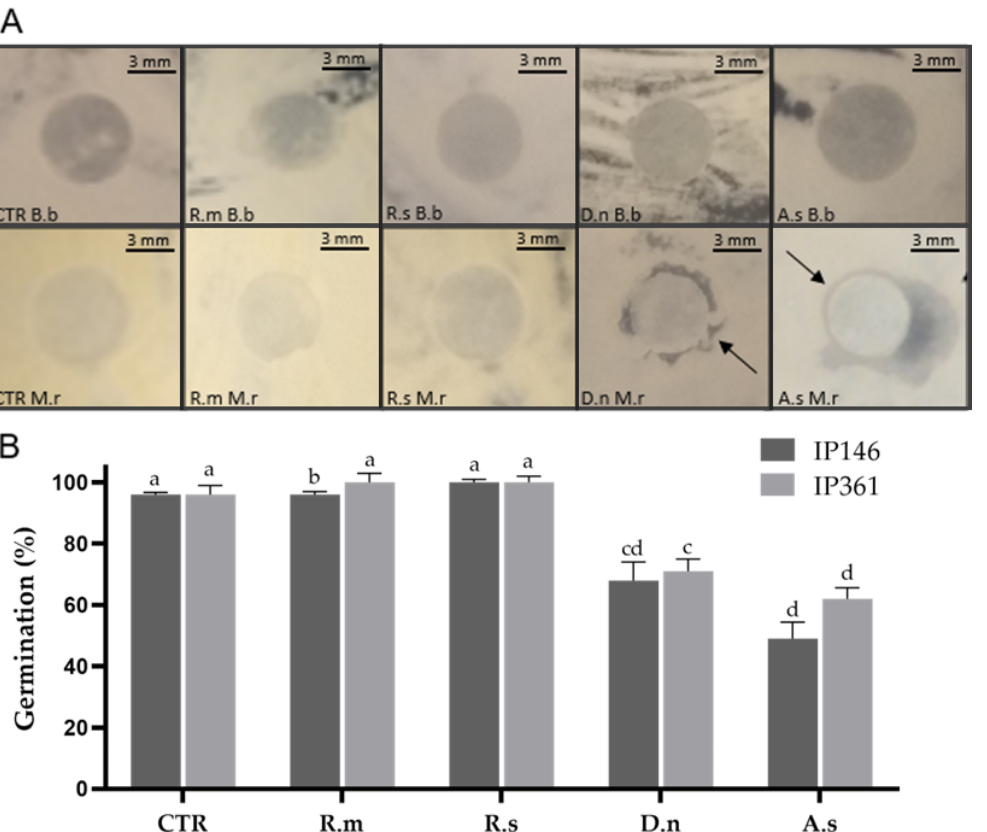
Figure 1. ( A ) Evaluation of the antifungal activity of the total compounds extracted from the cuticle of engorged females of Amblyomma sculptum (A.s), Dermacentor nitens (D.n), Rhipicephalus microplus (R.m) or Rhipicephalus sanguineus s.l. (R.s) at 48 h incubation. CTR Bb: Beauveria bassiana control; CTR Mr: Metarhizium robertsii control; Rm Bb: Lipid extract of R. microplus with B. bassiana ; Rm Mr: Lipid extract of R. microplus with M. robertsii ; Rs Bb: Lipid extract of R. sanguineus with B. bassiana ; Rs Mr: Lipid extract of R. sanguineus with M. robertsii ; Dn Bb: Lipid extract of D. nitens with B. bassiana ; Dn Mr: Lipid extract of D. nitens with M. robertsii ; As Bb: Lipid extract of A. sculptum with B. bassiana ; As Mr: Lipid extract of A. sculptum with M. robertsii . Black arrows indicate inhibition of fungal growth. ( B ) Conidial germination (%) of M. robertsii IP 146 or B. bassiana IP 361 treated or not treated (control; CTR) with lipids extracted from the cuticle of engorged females at 24 h incubation. Bars with the same letter do not differ significantly ( p > 0.05) by the Kruskal–Wallis test followed by the Student’s adjusted t -test.